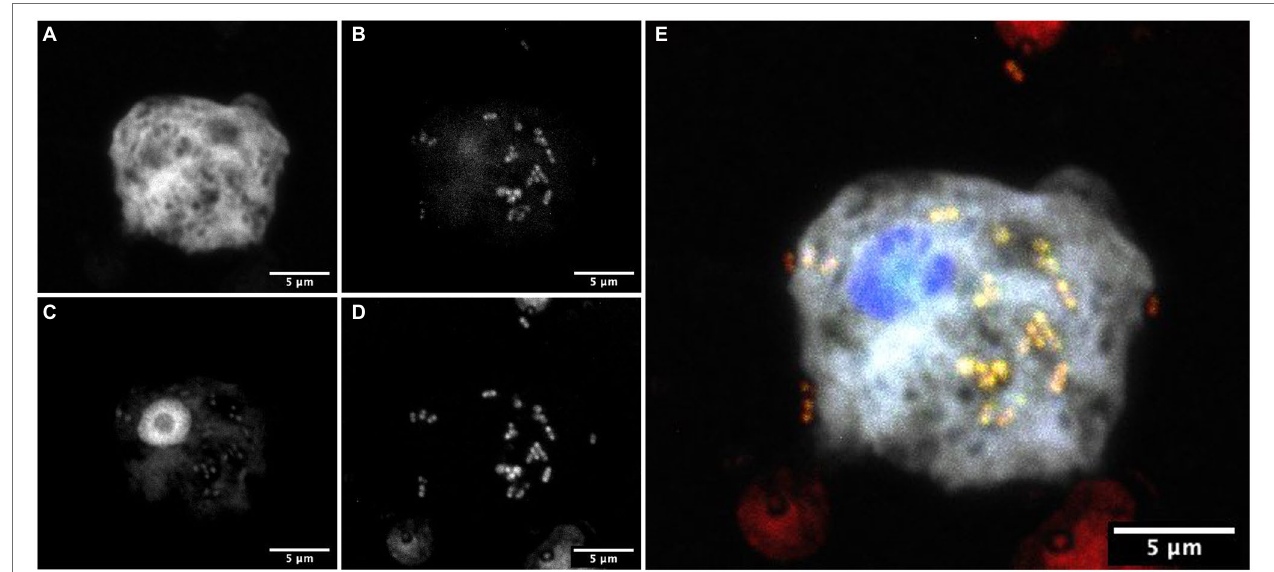
FIGURE 4 | FISH showing Dyella in association with Stemonitis sp. FISH was performed using (A) a Stemonitis- specific Cy5 probe; (B) EUB3338 I-III FITC probes for labeling eubacteria; (C) DAPI; and (D) a Dyella -specific probe Cy3 probe. (E) The composite image of all labeling highlights the superimposition of eubacteria- and Dyella -specific FISH. The bar length represents 5 μ m for all